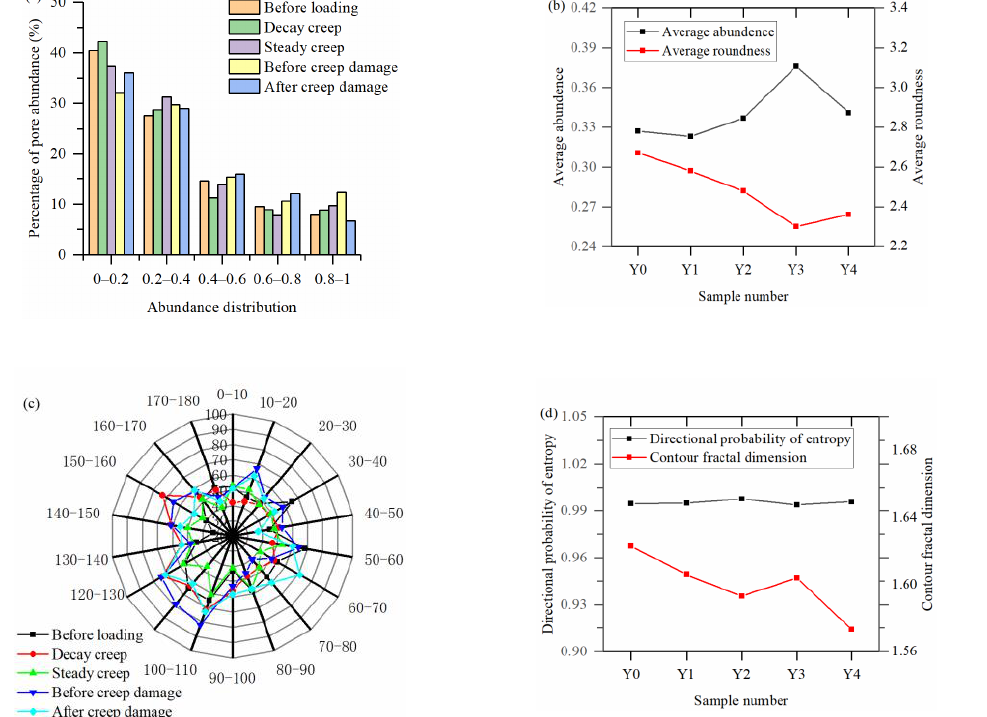
Figure 9. Quantitative analysis of pore space of intact soil. ( a ) Histogram of pore abundance distri- bution; ( b ) pore abundance and roundness; ( c ) frequency diagram of pore orientation distribution; ( d ) pore orientation probability and fractal dimension.